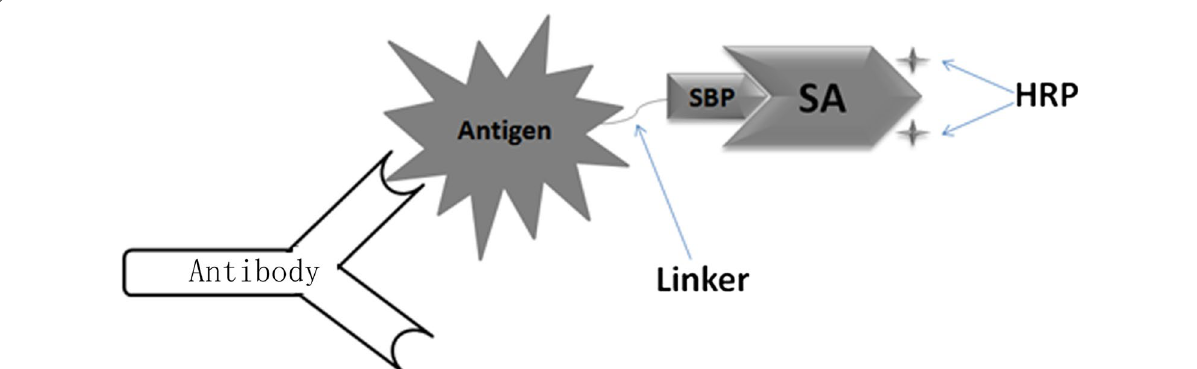
Fig. 1 Hsb‑Ag (shown in gray) and its binding to antibody. SBP is fused to antigen by a linker. The recombinant antigen is able to bind to HRP labeled streptavidin (SA) with high affinity and retention of reactionogenicity. In this report, the antigen and specific antibody are Cap∆41 and PCV2 antibody,